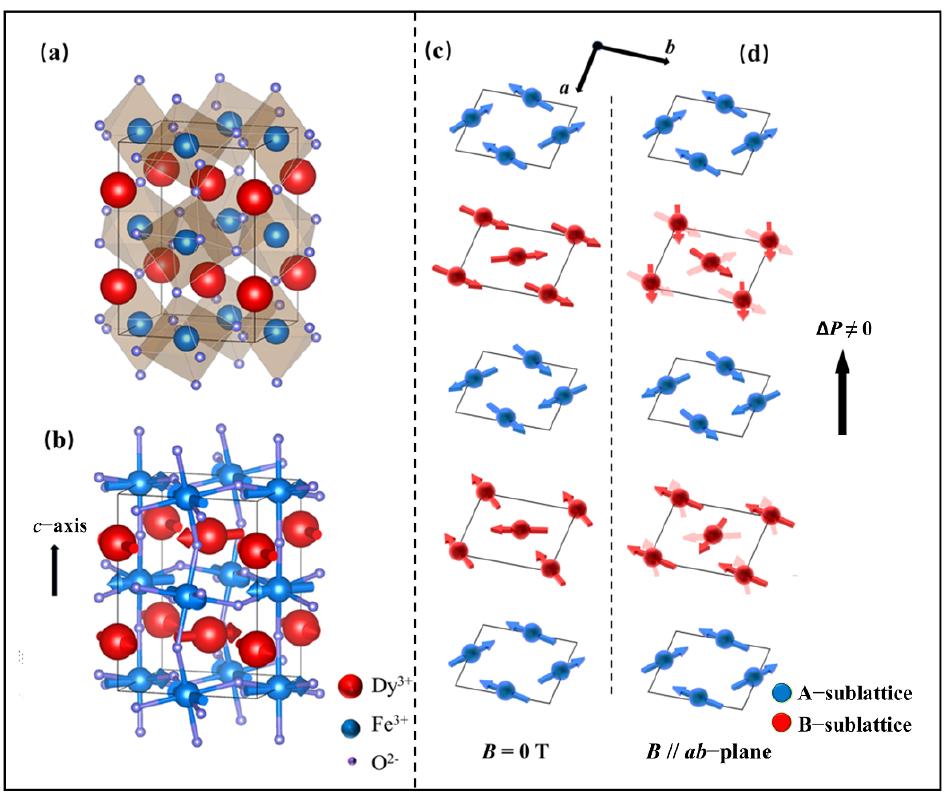
Figure 1. ( a ) The crystal structure and ( b ) magnetic configuration of DyFeO 3 below the Dy 3+ ordering temperature. Two AFM sublattices nesting with each other at ( c ) zero field and ( d ) applied magnetic field.